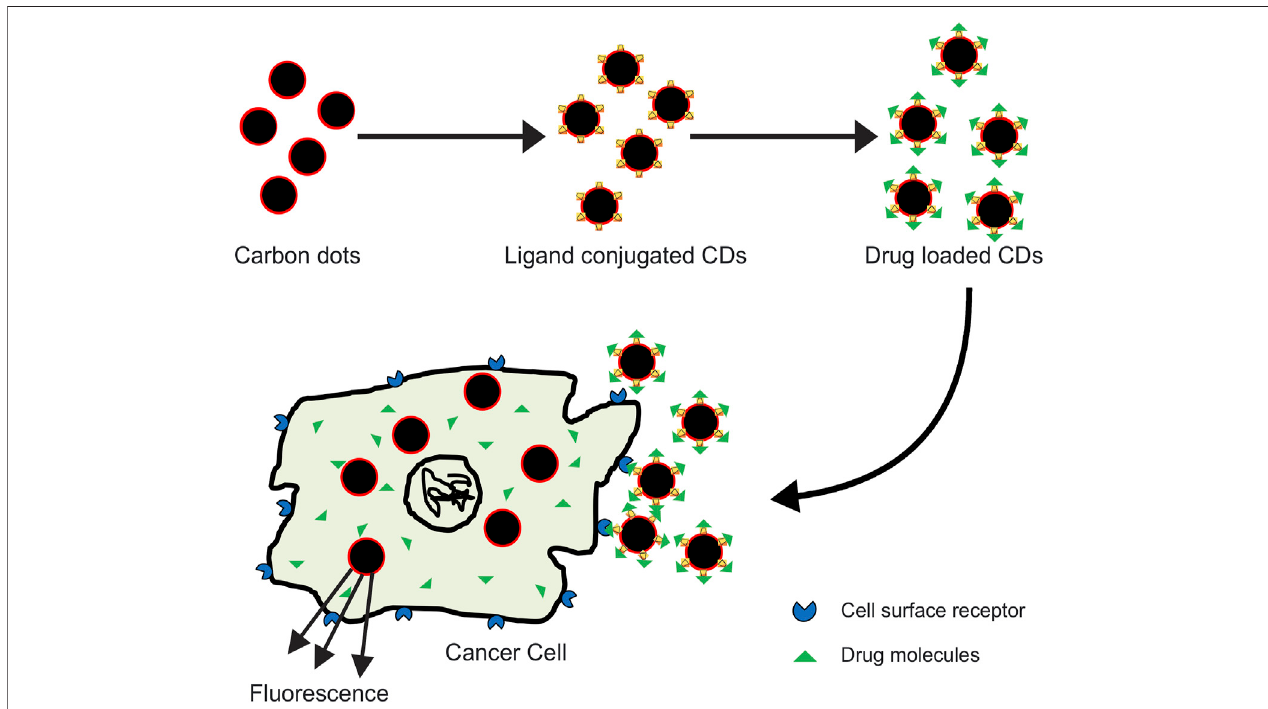
FIGURE1| Differentprocessesinvolved intheprogressionofmalignantneoplasm. Subjectinganormalcelltocarcinogenicagents disruptsDNA repairmachinery ofthecell,inducingDNAdamage.Thisactfurthertriggersactivationofoncogenes,inhibitionoftumorsuppressorgenes,and fi nallyleadstoapoptosis.Theseprocesses altogether contribute to uncontrolled cell differentiation, growth, and ultimately forming malignant neoplasms.